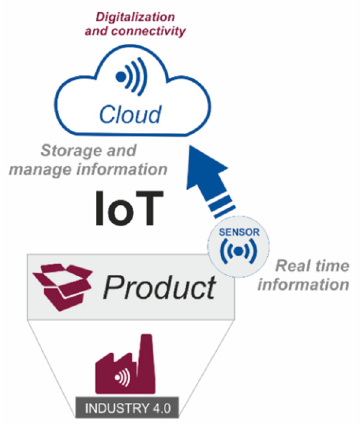
Figure 3. Sensors / Cloud / (connectivity) / Storage (connectivity). Figure 3. Sensors/Cloud/(connectivity)/ Storage (connectivity).